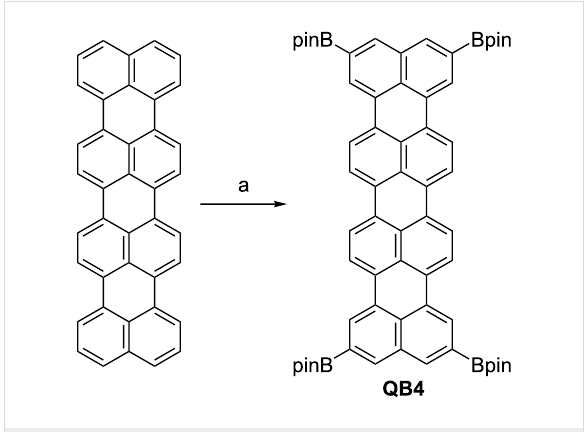
Taking the successful result of the terrylene borylation, next we tried to perform the same reaction to quaterrylene (Scheme